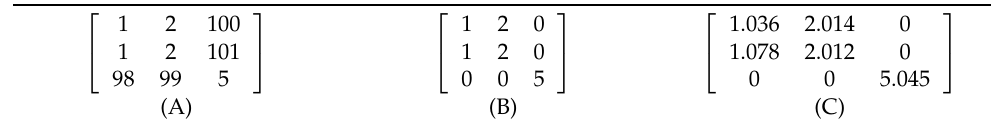
Table 1. The matrices used in Example 1.